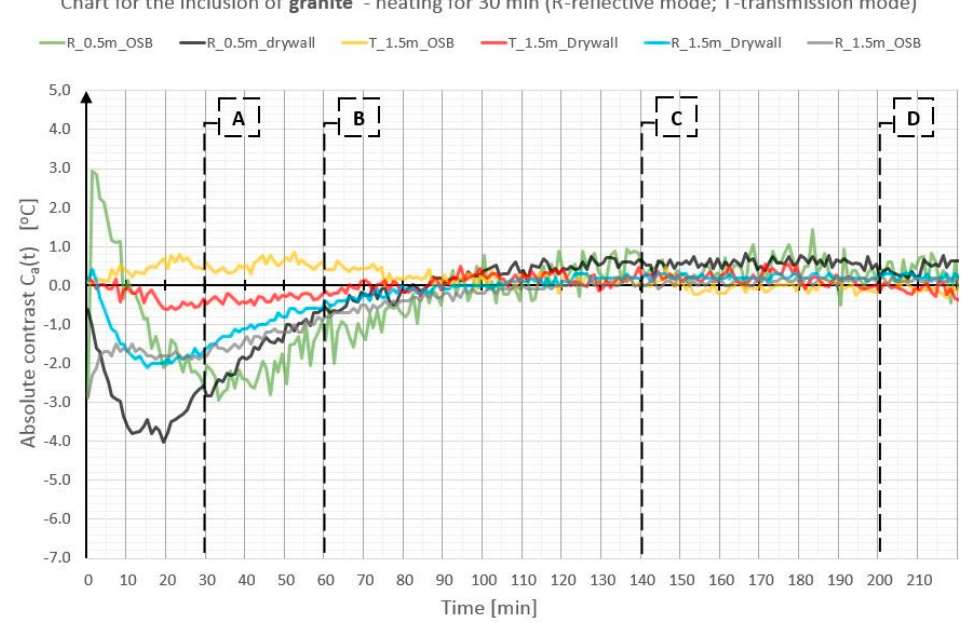
Figure 11. Comparison of absolute contrasts in a reflection mode and in a transmission mode for material inclusion made of granite.